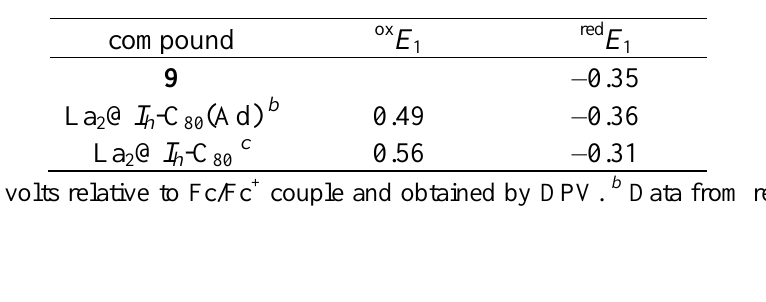
Table 1. Redox potentials of La